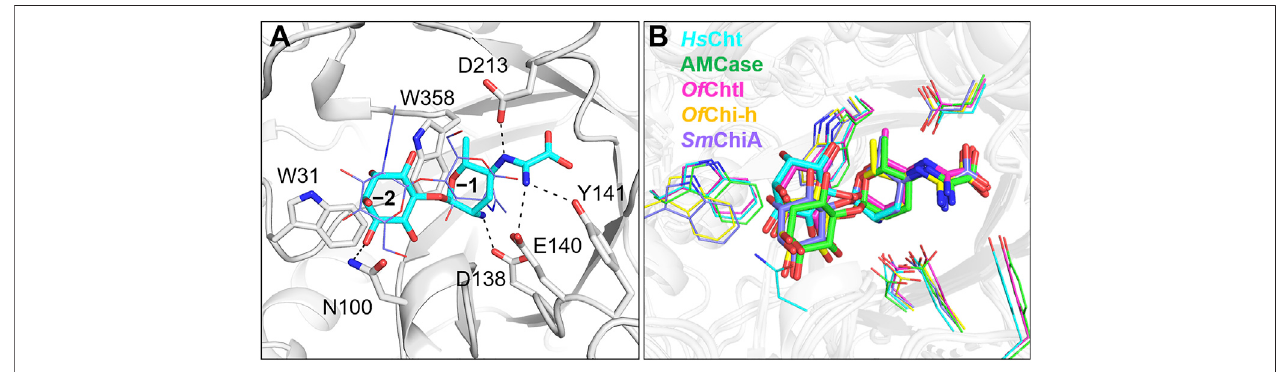
FIGURE 2 | Modeled structures of kasugamycin in complex with GH18 chitinases. (A) Modeled binding mode of kasugamycin to Hs Cht. (B) Superposition of the modeled conformations of kasugamycin in different GH18 chitinases. Cyan in Hs Cht, green in AMCase, pink in Of ChtI, yellow in Of Chi-h and purple in Sm